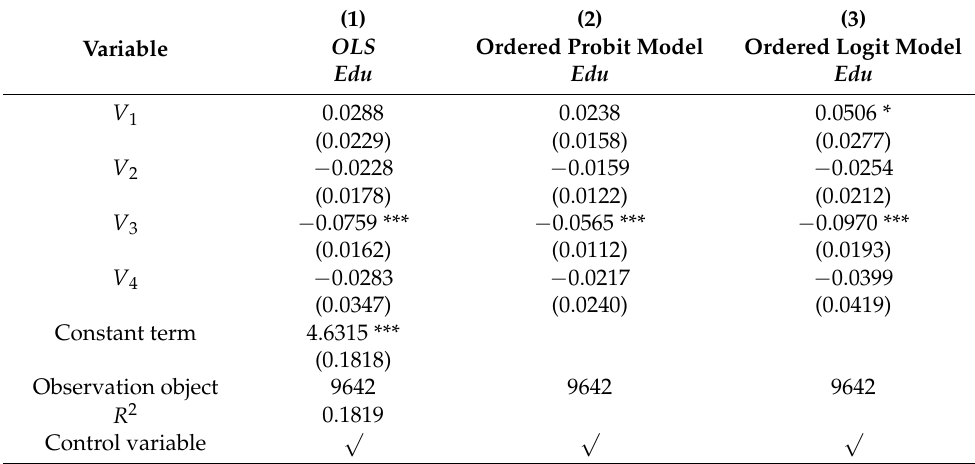
Table 5. Results of the dimensional heterogeneity